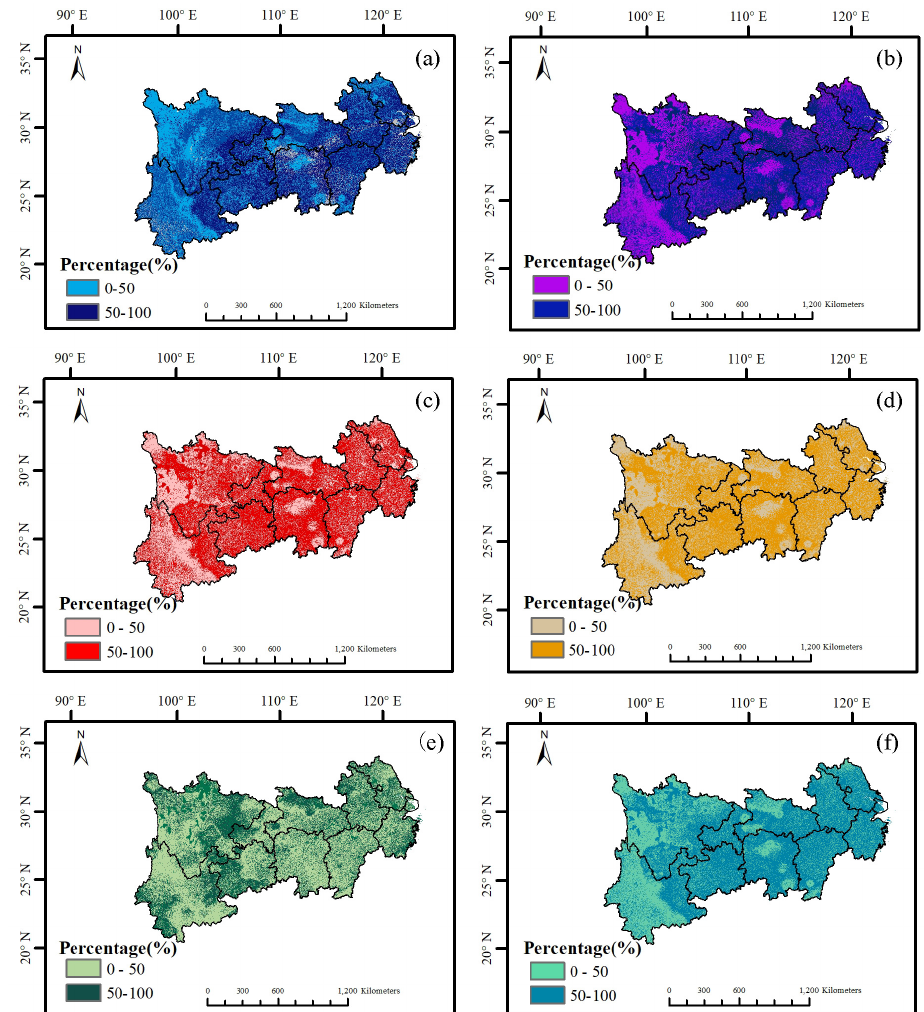
Figure 8. The attribution weights of human activities ESs and ESV in the YREB during 1999–2018 (( a ): water yield; ( b ): soil retention; ( c ): water purification-nitrogen; ( d ): water purification-phosphorus; ( e ): NPP; ( f ): integrated ESV). Table 2. The contribution rate of climate change and human activities to ESV in the YREB during